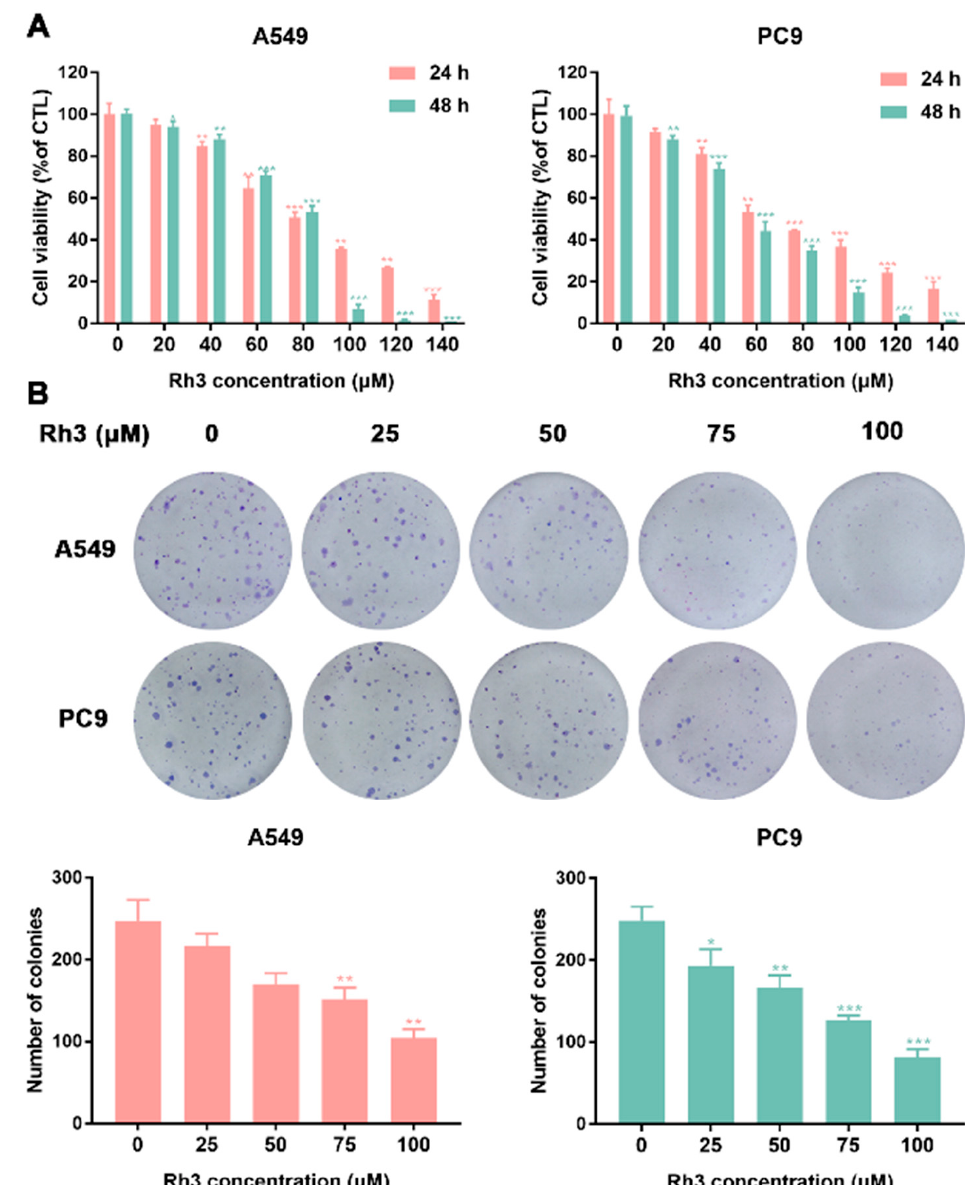
Figure 1. Ginsenoside Rh3 suppresses the growth of lung cancer cells in vitro. ( A ) Human lung cancer cells (A549 and PC9) were treated with different concentrations (0–140 μ M) of Rh3 for 24 h or 48 h. Cell viability was measured by MTT assay. Rh3 suppresses the proliferation of A549 and PC9 cells in a dose- and time-dependent manner. ( B ) Colony formation assay in A549 and PC9 cells with control or Rh3 (25–100 μ M) treatment. * p < 0.05, ** p < 0.01, *** p < 0.01 compared with the